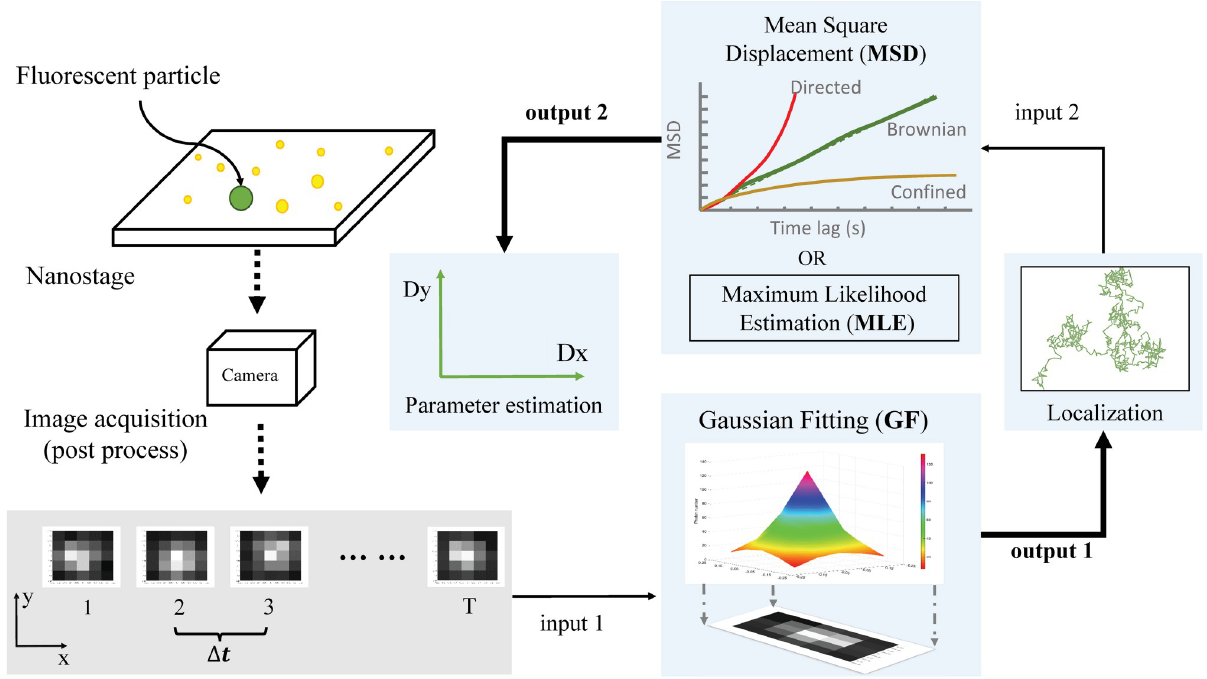
Fig 1. Illustration of the standard approach. Segmented image data is first passed through a localization step where an algorithm such as GF determines the position of the particle in each frame. The resulting trajectory is then analyzed using, e.g., the MSD or MLE to determine model